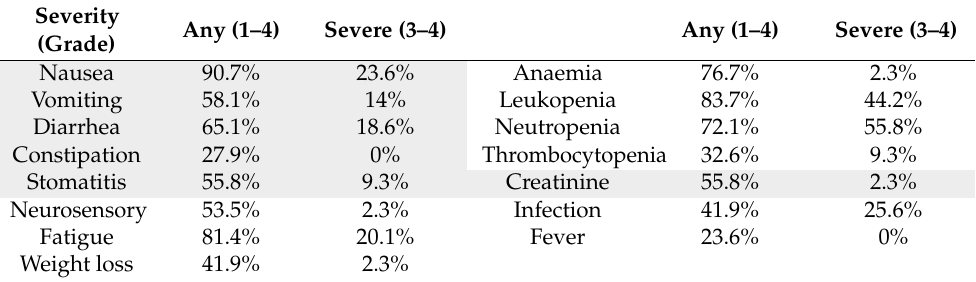
Table 4. An example of an incidence and severity of cisplatin acute toxicities in cancer